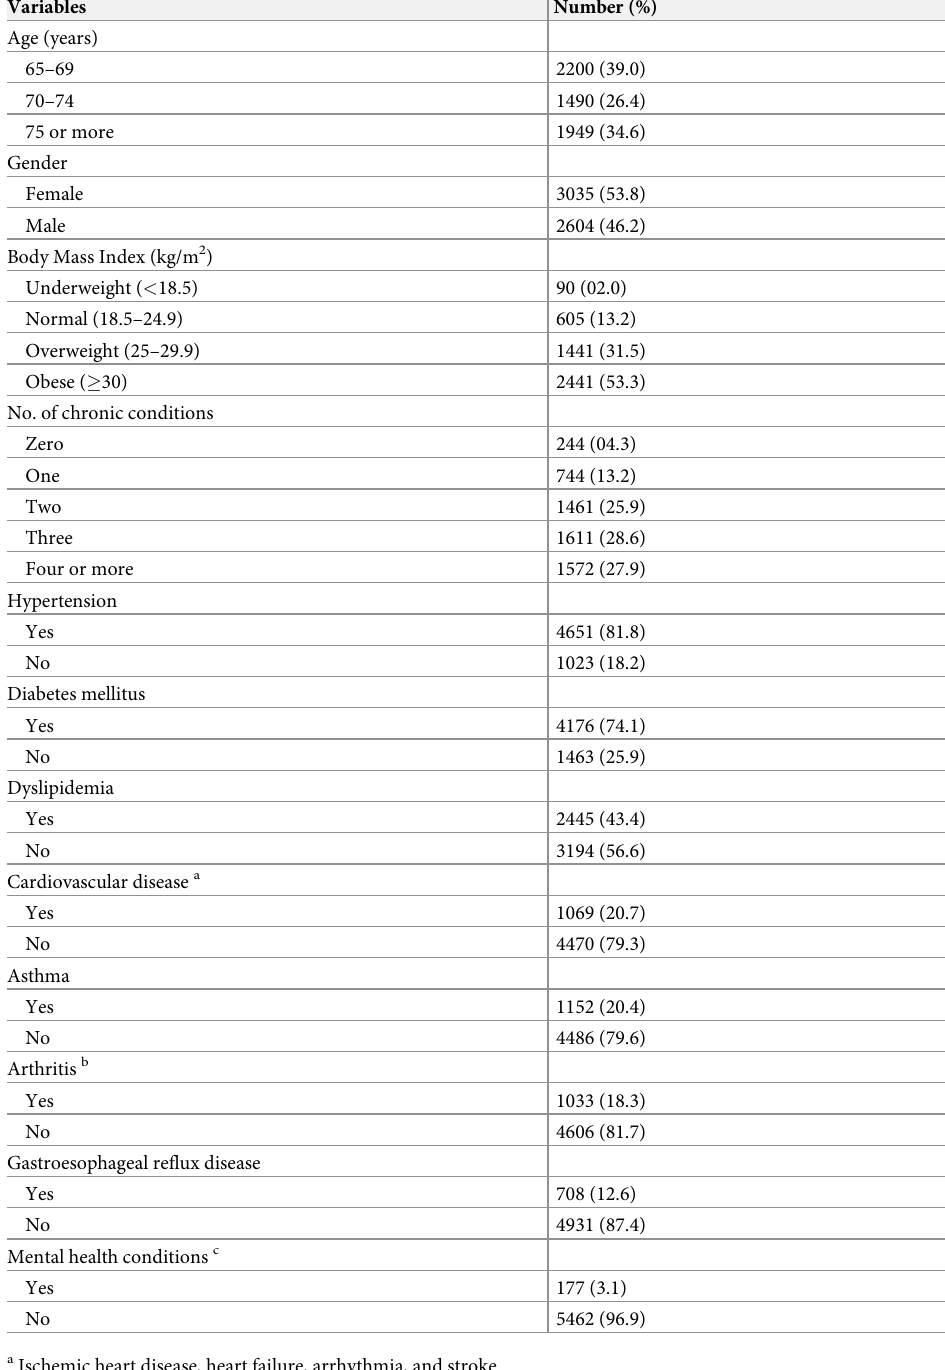
Table 1. Background characteristics of the study population (N =